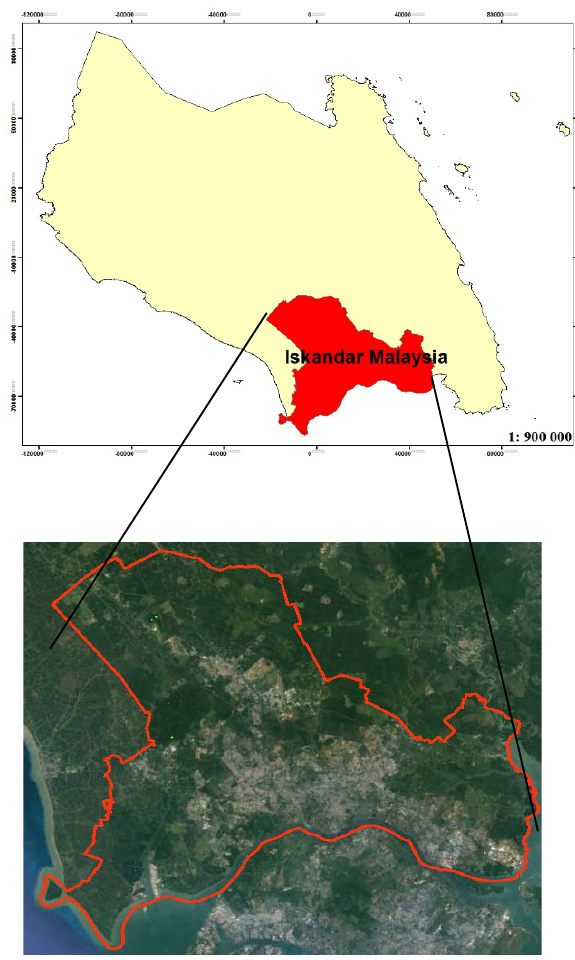
Figure 1. The Iskandar Malaysia (IM) region in Johor State of